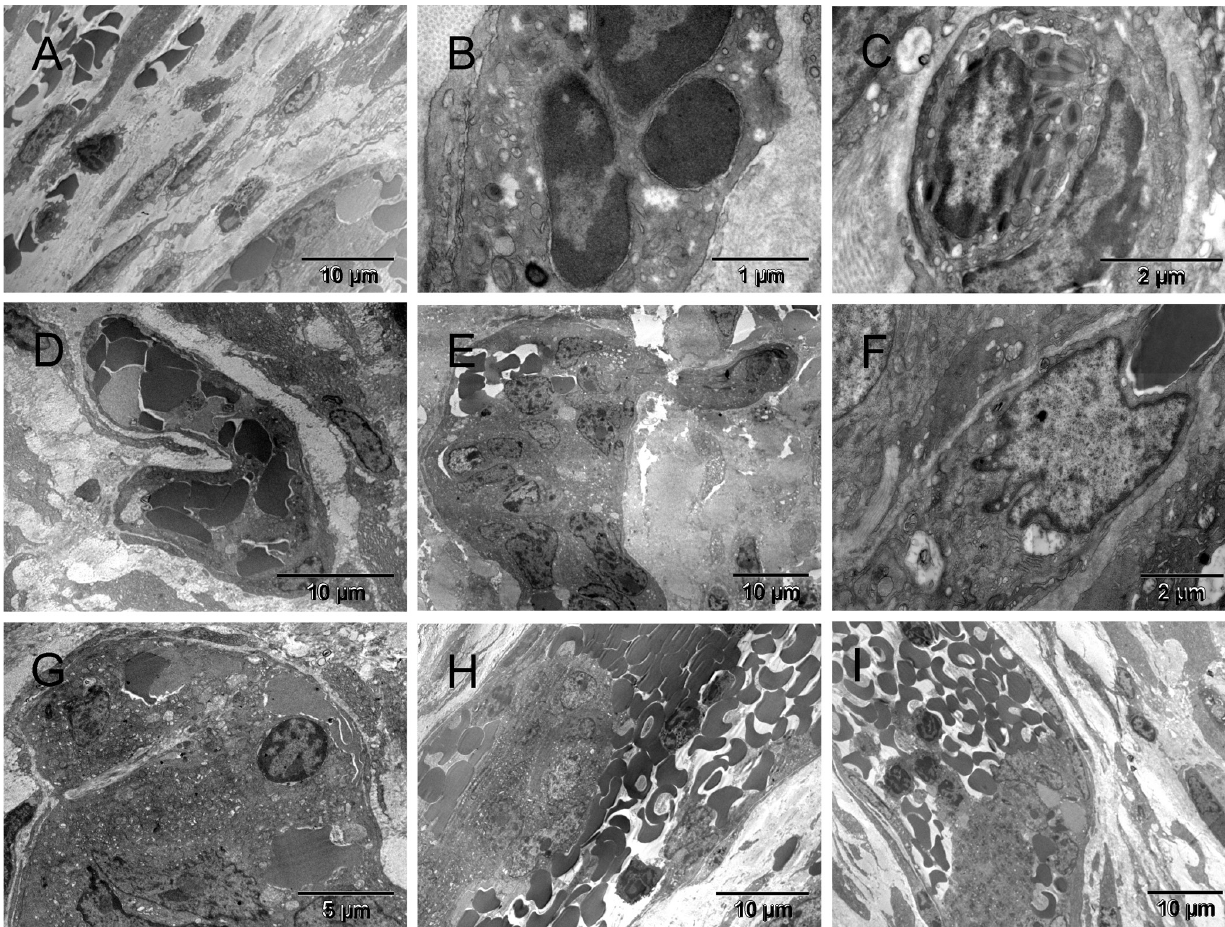
Figure 1. Delay in tumor vasculature development and capsular vaso-mimicry in the ectopic environment. Three weeks after implantation, the tumor environment consisted of single migrating cells that were secreting ECM components, mainly collagen, and others converting into erythrosomes [ A ]. The erythroblast [ B ] and the eosinophil [ C ] were each in contact with a nucleated supporting cell on one side. A small primitive vessel located next to the tumor [ D ] resembled those early ones seen in pseudo-orthotopic environment five days after implantation (Figure 2 in 41 ). Tumor cells were encapsulated by fibroblasts and the cell population inside the capsules appeared heterogeneous. There were erythrosomes [ E ] and nuclei of some cells had sinuses [ F & G ] similar to those in ECs of a forming artery (Figure 8 in 41 ). Featured in [ H ] is a part of larger elongated capsule containing a cluster of tumor cells in the center and multiple erythrosomes around it, all covered with typical flat, collagen producing fibroblasts, whereas a similar structure in [ I ] contained mainly erythrosomes and platelets. Both were remarkably similar to a